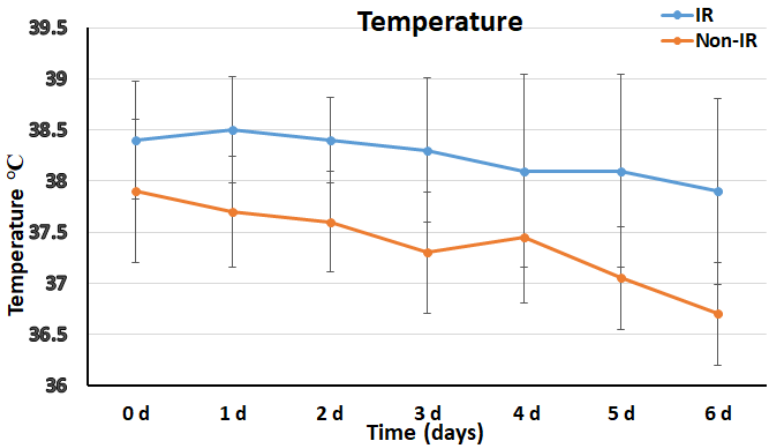
Figure 3. Postoperative distribution and trends of the body temperature in the IR and non-IR group.